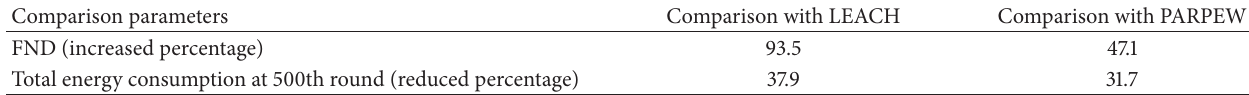
Table 3: The percentage of comparison of lifetime and energy consumption of network.